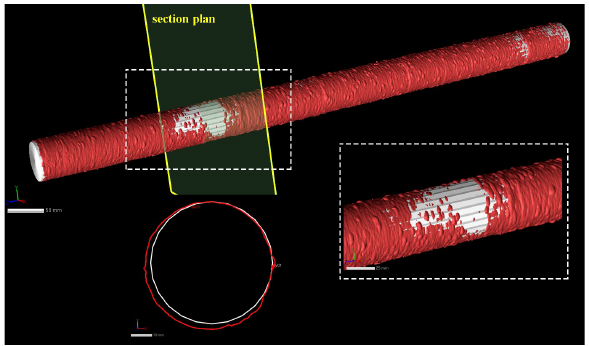
Figure 11. 3D model of the tubular specimen, in red, and in white the ideal design cylinder, with a transversal section shown below; in the dashed rectangle a detail of the two